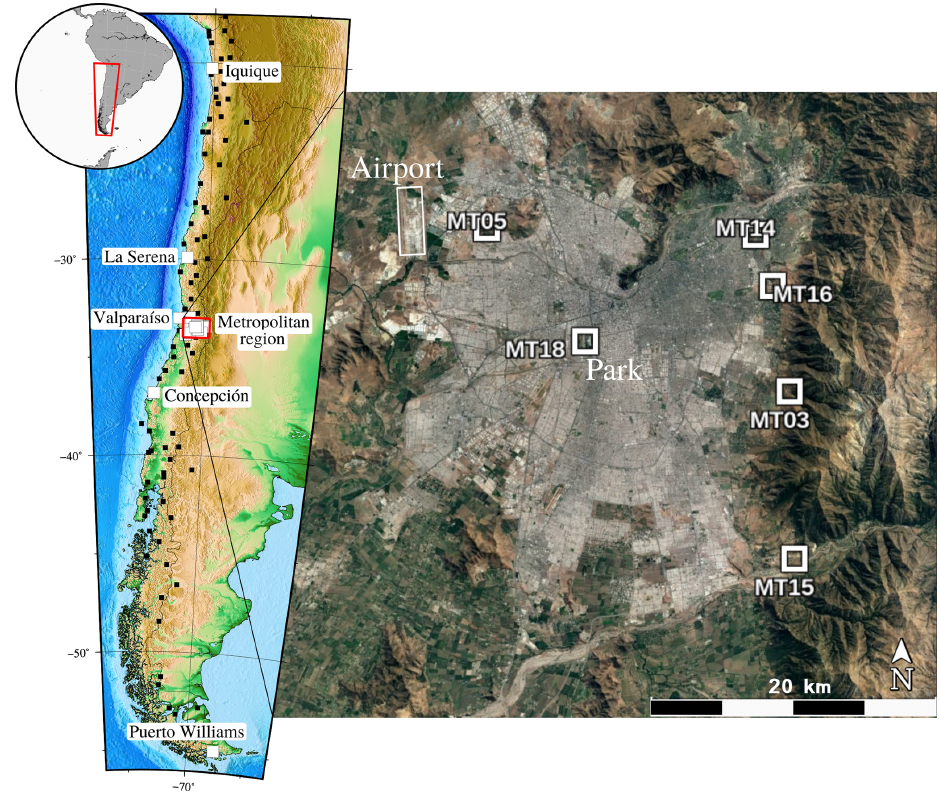
Figure 1. Location of the seismic stations of Chilean seismological network. Inset map shows the study location with reference to South America. The small black square corresponds to the broadband stations managed by CSN. White squares correspond to the five stations analysed in Iquique, La Serena, Valparaíso, Concepción, and Puerto Williams. The red rectangle shows the MR with six stations located in urban areas (squares with white contours). We have also shown the location of the airport and O’Higgins Park. Photos from © Google